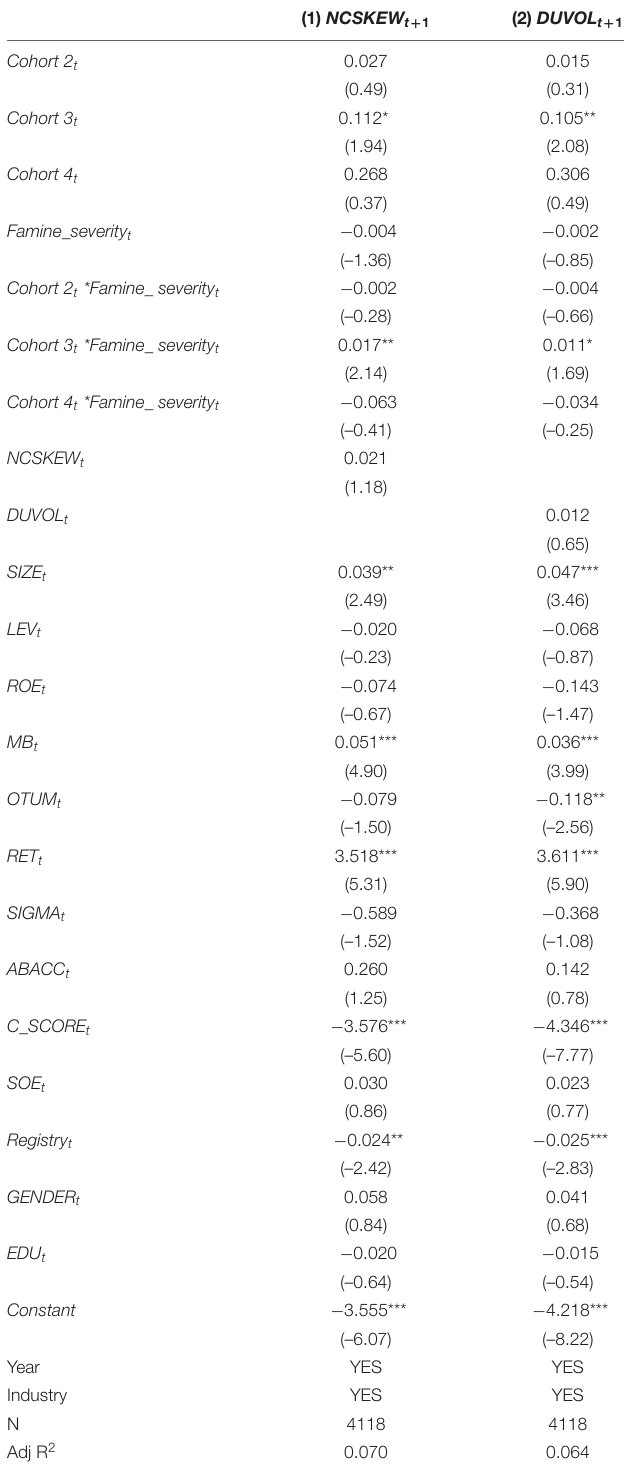
TABLE 7 | Difference-in-difference estimation by using different cohorts and famine